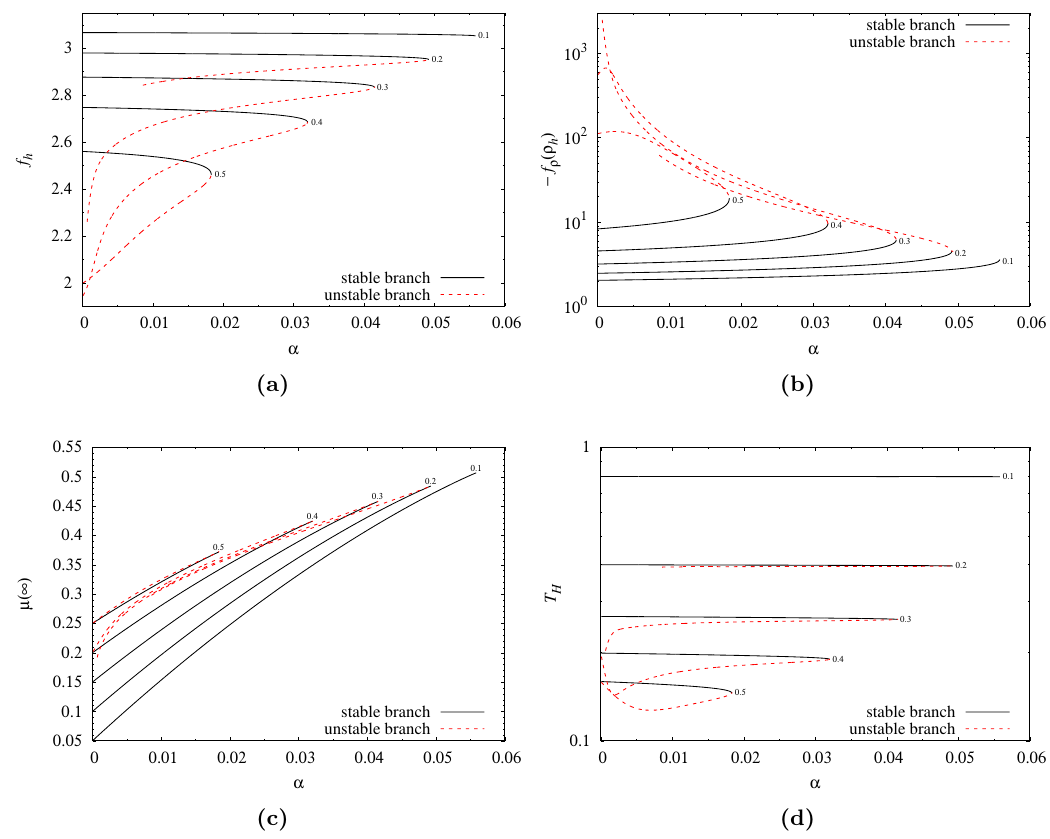
Figure 19 . Stable (black solid lines) and unstable (red dashed lines) branches of solutions in the 2+8 model with (cid:13) = 1: (a) the value of the pro(cid:12)le function at the horizon, f h ; (b) the derivative of the pro(cid:12)le function at the horizon, f (cid:26) ( (cid:26) h ); (c) the ADM mass, (cid:22) ( 1 ); (d) the Hawking temperature T H , all as functions of the gravitational coupling, (cid:11) . The numbers on the (cid:12)gures indicate